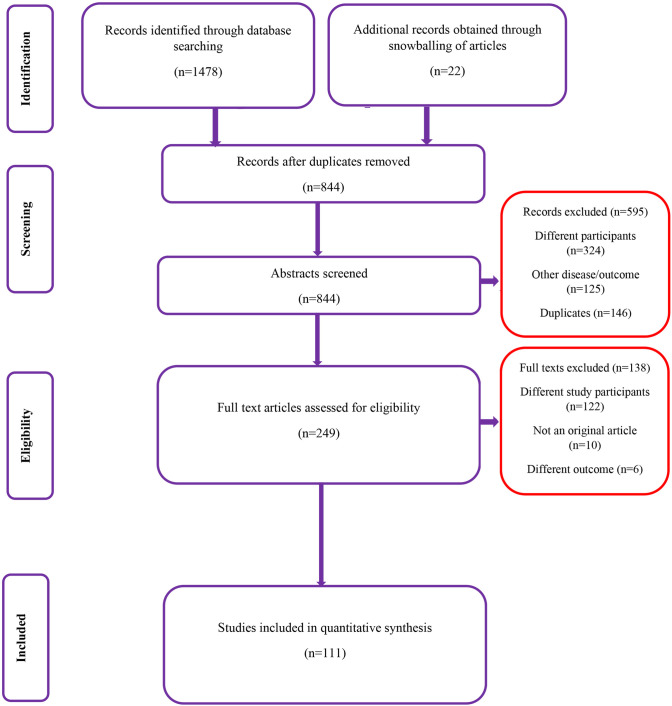
Flow chart showing the search strategy and selection of studies.